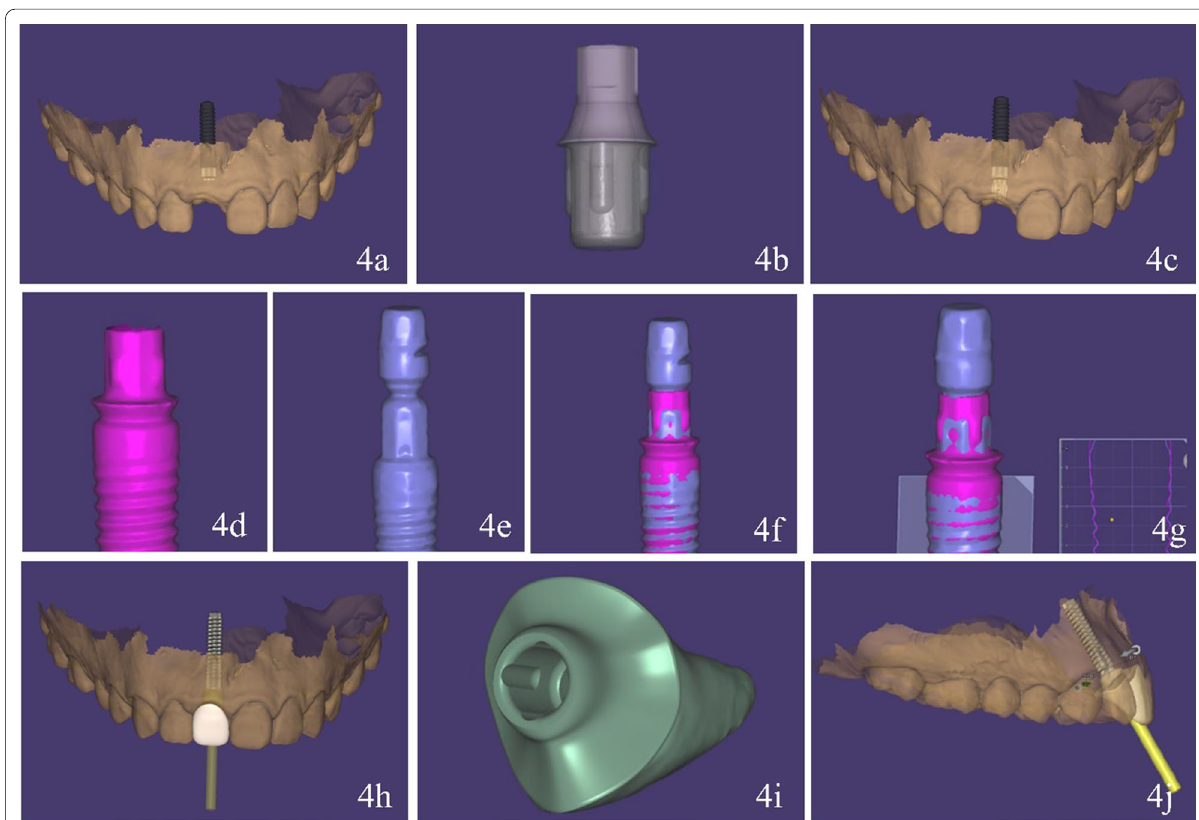
Fig. 4 Design of implant-supported interim restoration based on designed implant position. a Scene files loaded. b selected virtual abutment (Straumann NC, Variobase, Straumann USA). c Virtual abutment selected. d Scan of the implant screwed with abutment. e Scan of the implant screwed with implant carrier. f Two scans were superimposed to find out the direction relationship between the implant carrier and the abutment to help bonding the crown to the abutment. g Accuracy of the superimposing process was reliable. h Design of implant-supported interim restoration based on selected virtual abutment. i Concave emergence profile designed. j interim restoration fit to the abutment